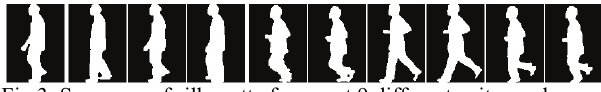
Fig.3. Sequence of silhouette frames at 9 different gait speeds